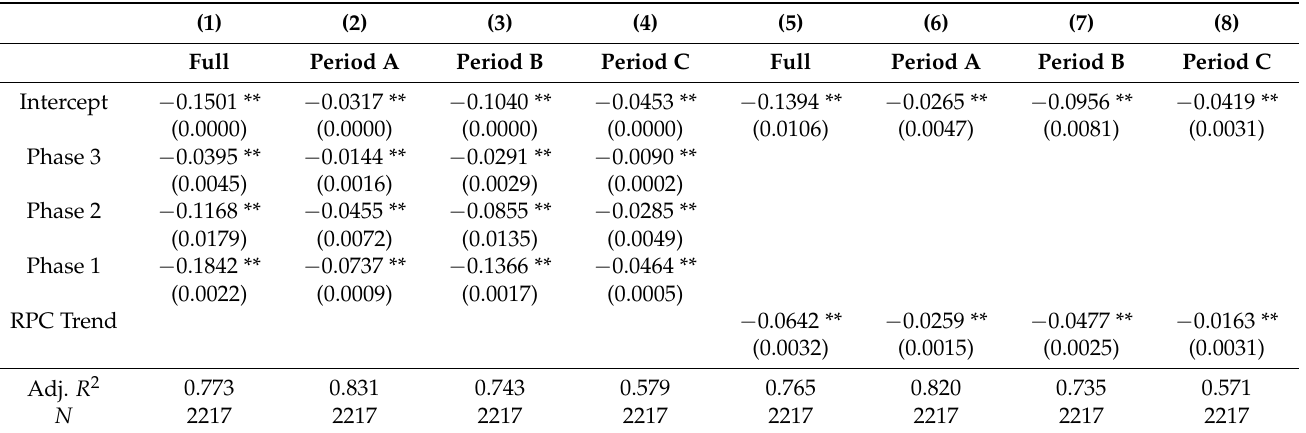
Table 6. Portfolio Category Drawdown